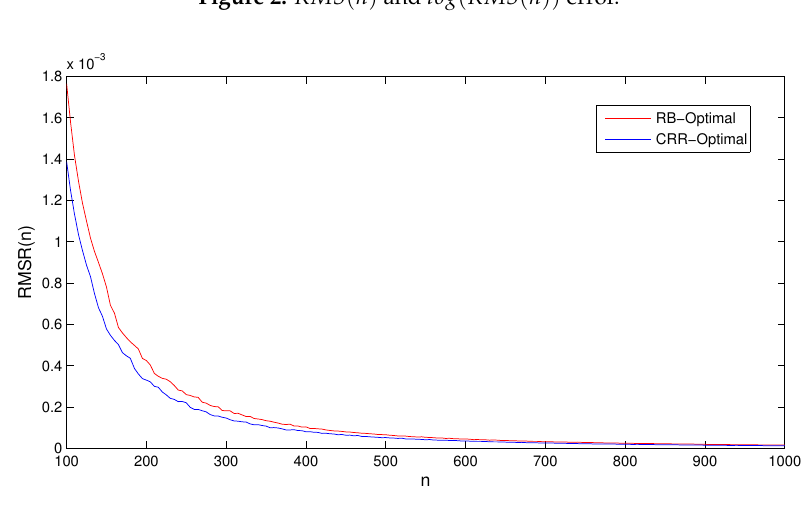
Figure 2. RMS ( n ) and log ( RMS ( n )) error.